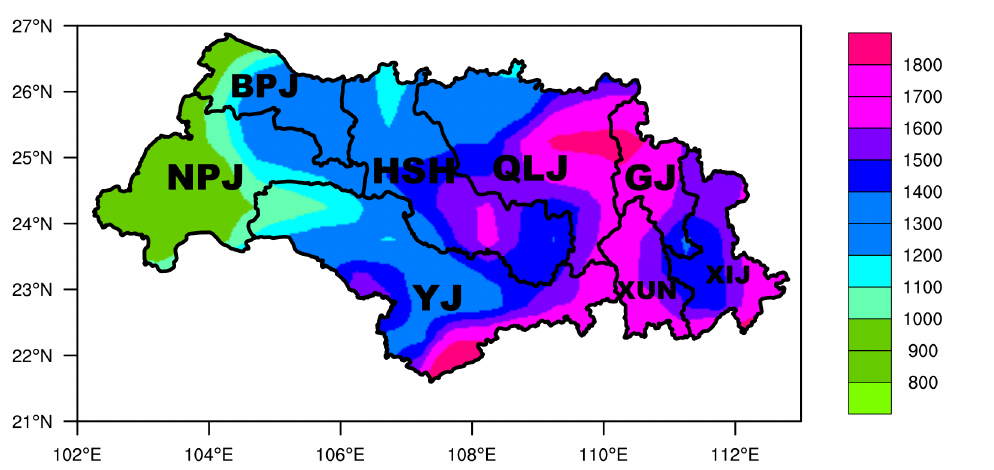
Figure 2. Mean annual precipitation (mm/year) for the 1980–2010 period from the National Oceanic and Atmospheric Administration’s Climate Prediction Center (CPC) unified gauge-based